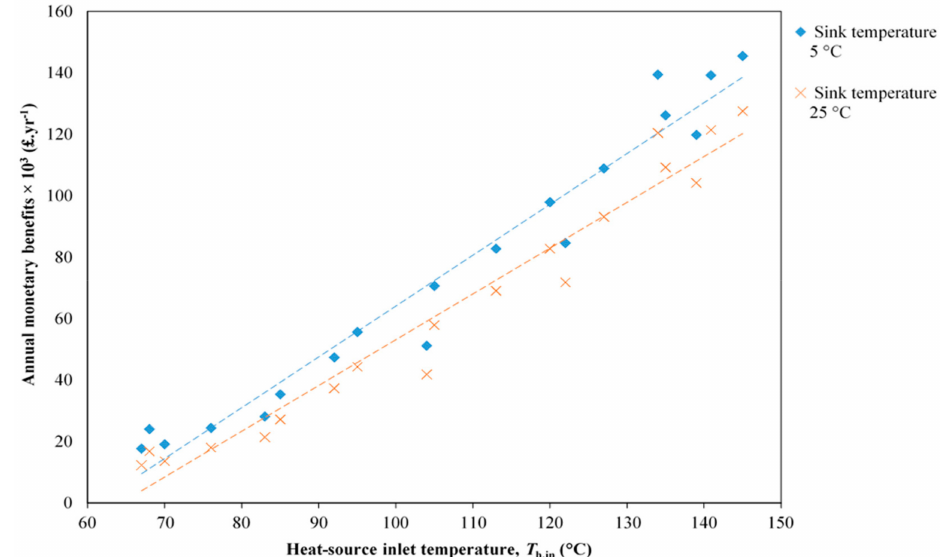
Figure 11. Annual monetary benefits arising from the generation of electricity with ORC engines as a function of the heat-source inlet temperatures which range between 65 and 145 ◦ C when utilizing thermal energy available in the streams in Table 5 with sink temperature at 5 and 25 ◦ C. Based on the electricity price in China (Appendix A), as an example